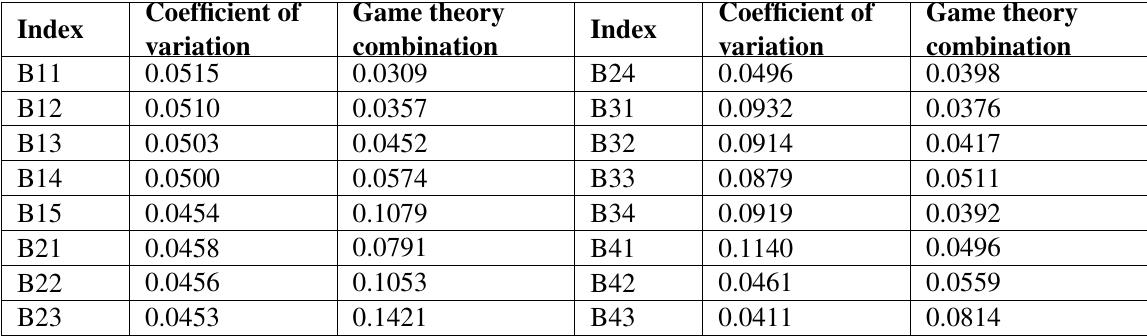
Table 7 The method of coefficient of variation and game theory to determine the weight distribution of indicators